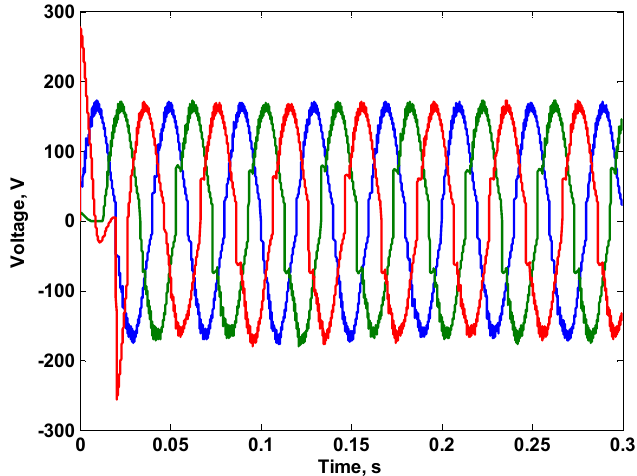
Figure 21. Motor Speed when Excited with 220 V, 50 Hz.